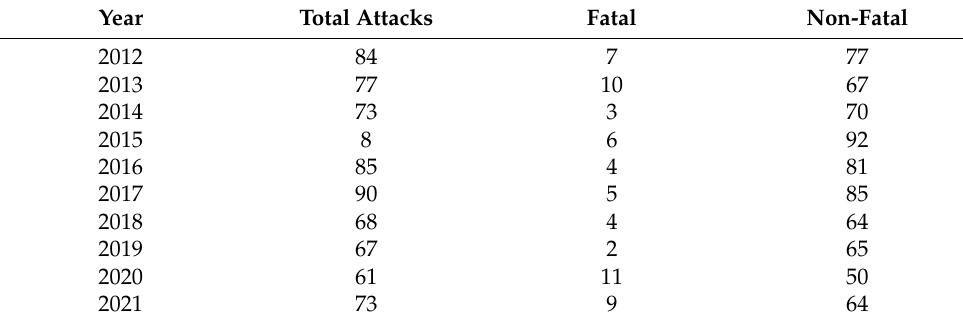
Table 1. International Shark Attack File: World unprovoked